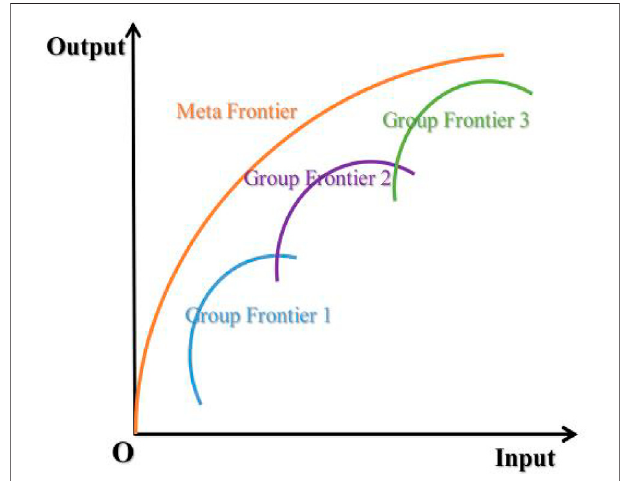
FIGURE 2 | Meta Frontier structure.